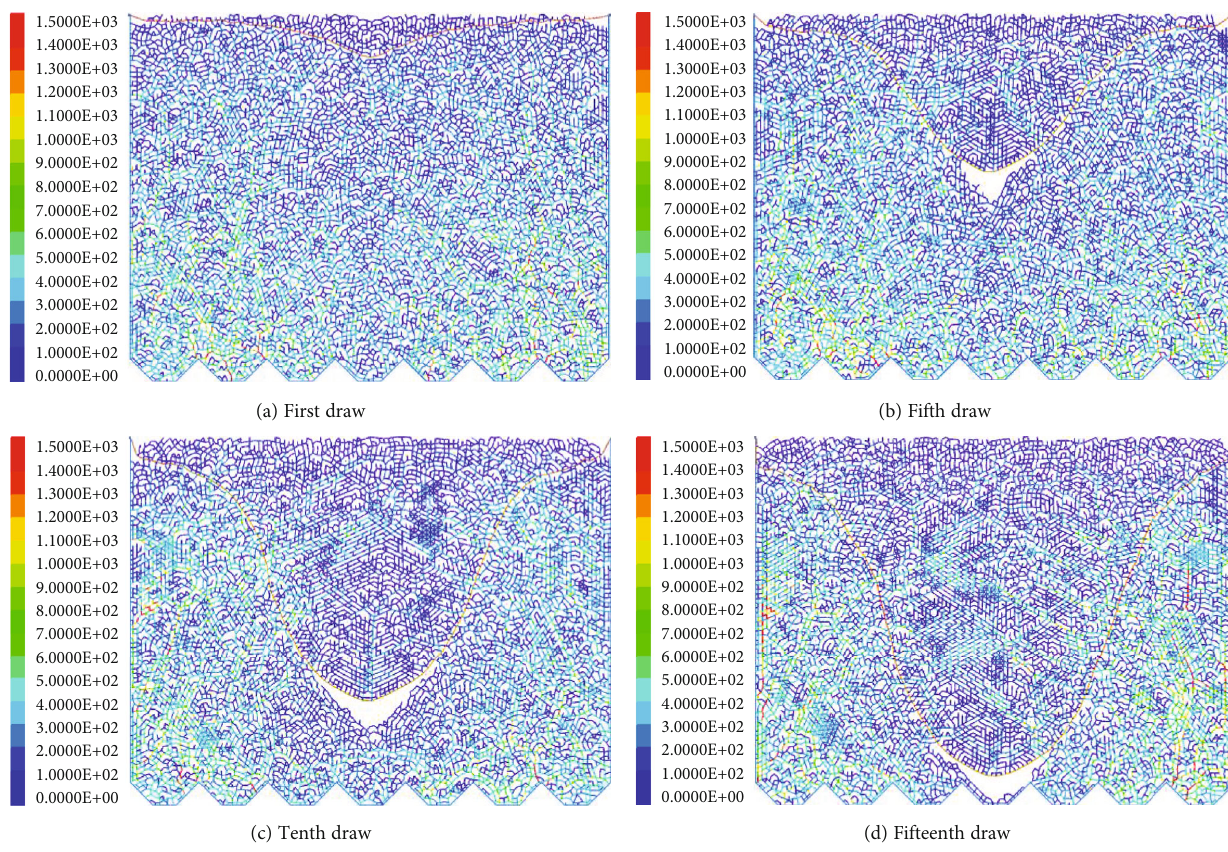
Figure 4: Contact force distribution of ore particles during the ore